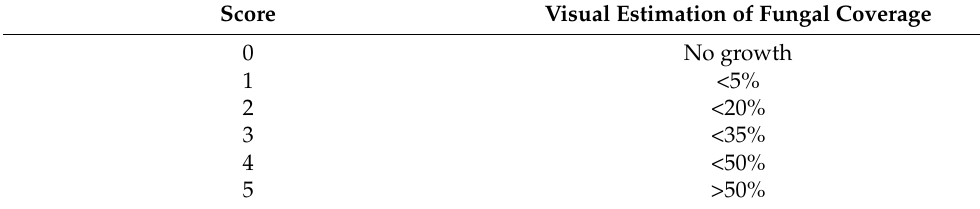
Table 1. Score criteria used by volunteers to assess blindly the fungal growth in skin samples. The score corresponds to the visually estimated percentage of the surface area of each skin piece covered by fungal growth. Score Visual Estimation of Fungal Coverage